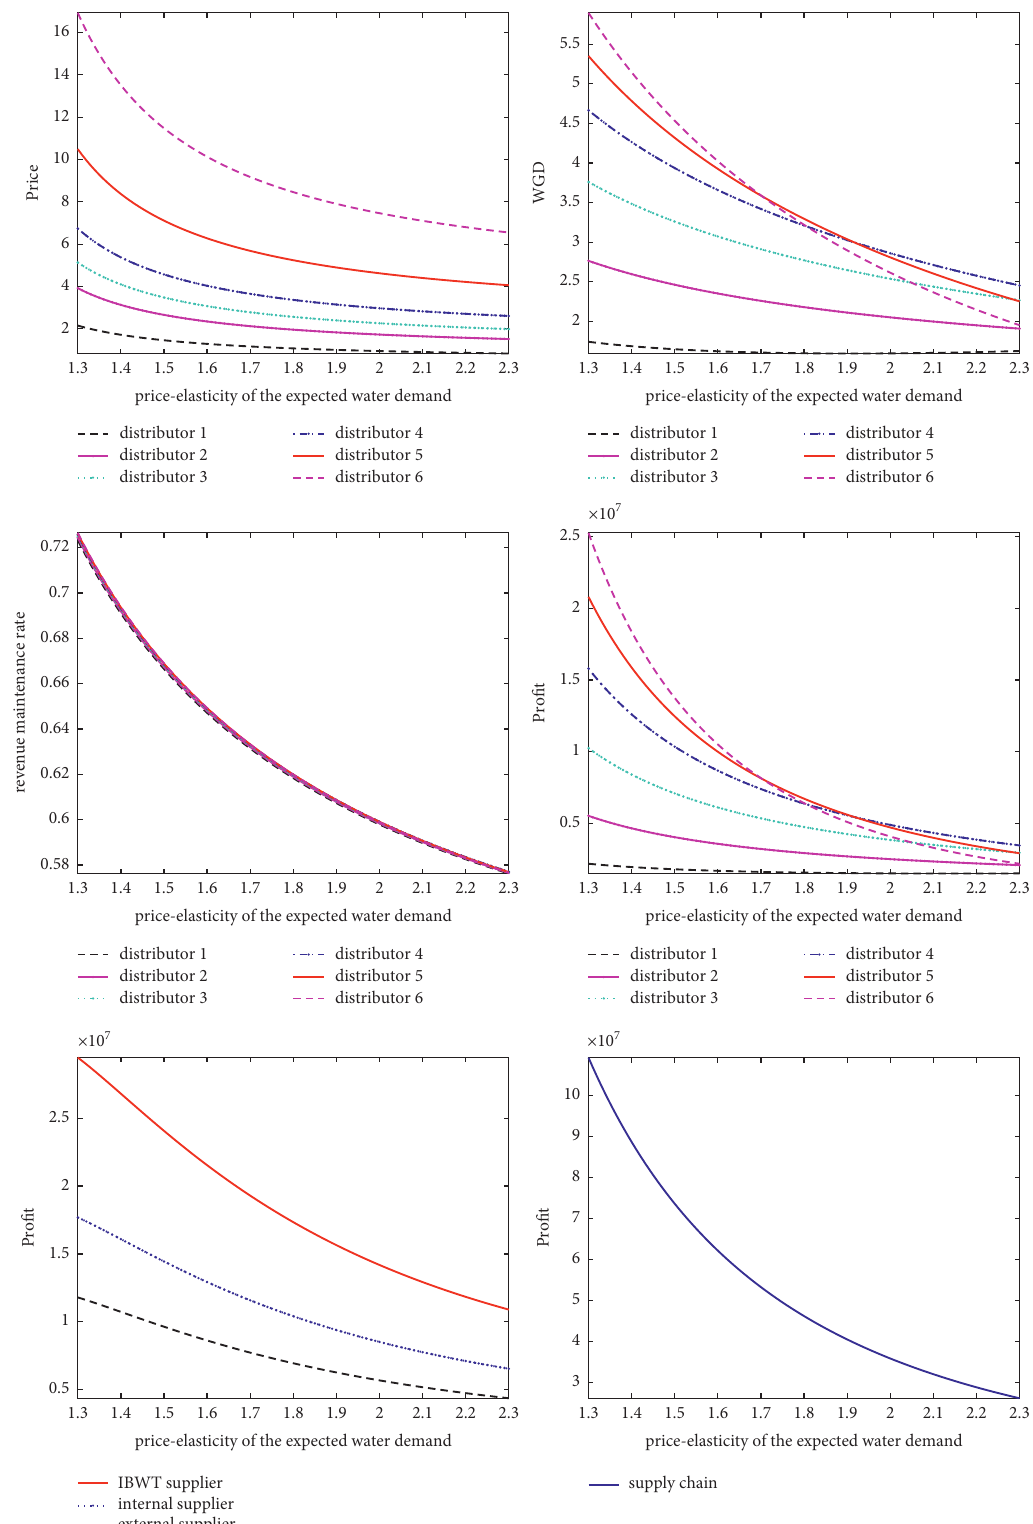
Figure 3: Sensitivity analysis of price-elasticity index of the anticipated demand